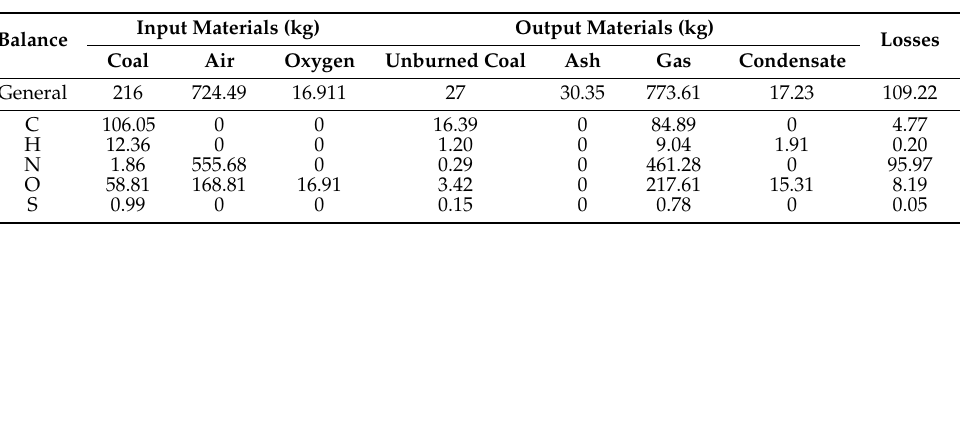
Table 2. The general and atomic balance values obtained from the first experiment calculations. Balance